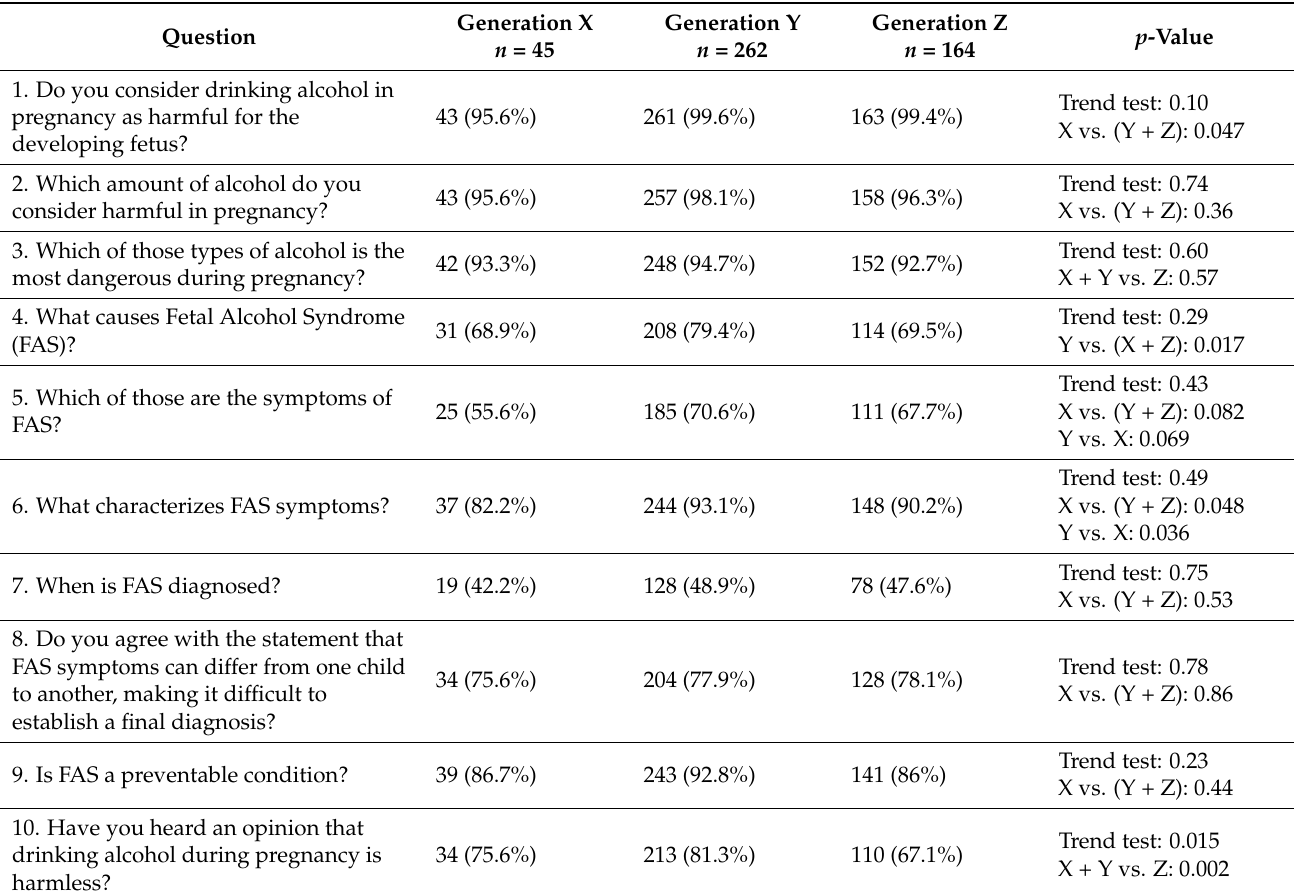
Trend comparison for 3 groups (X vs. Y vs. Z): Cochran-Armitage Trend Test, comparison 2 groups: chi2 test with Yate’s correction or Fisher’s exact